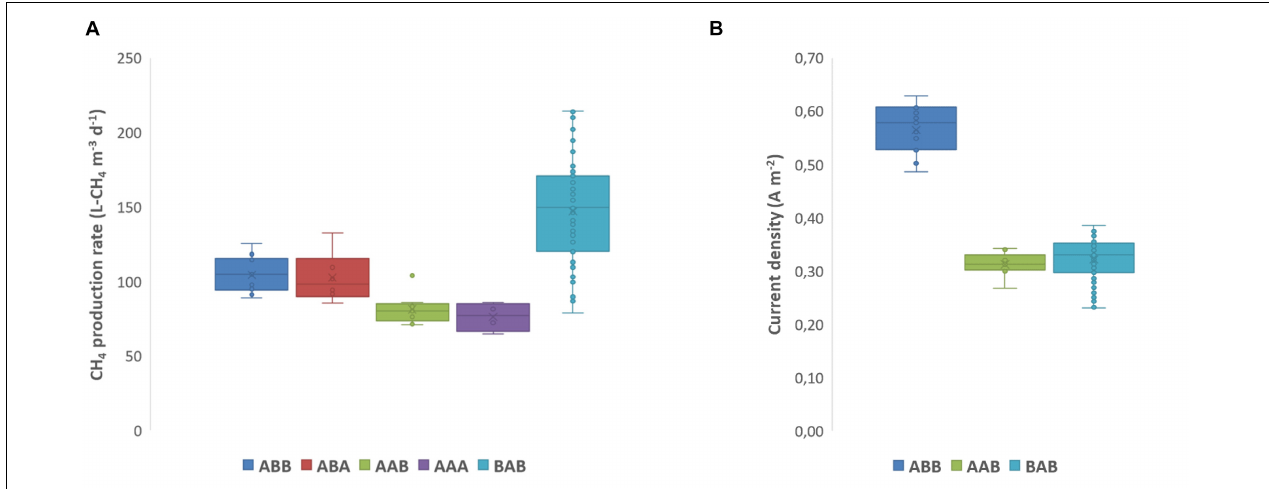
FIGURE 3 | CH 4 production rate (A) and current density (B) measured in tested operation conditions. ABB condition refers to days 90 to 118, when stationary phase was reached; current density was null in ABA and AAA conditions (OCV